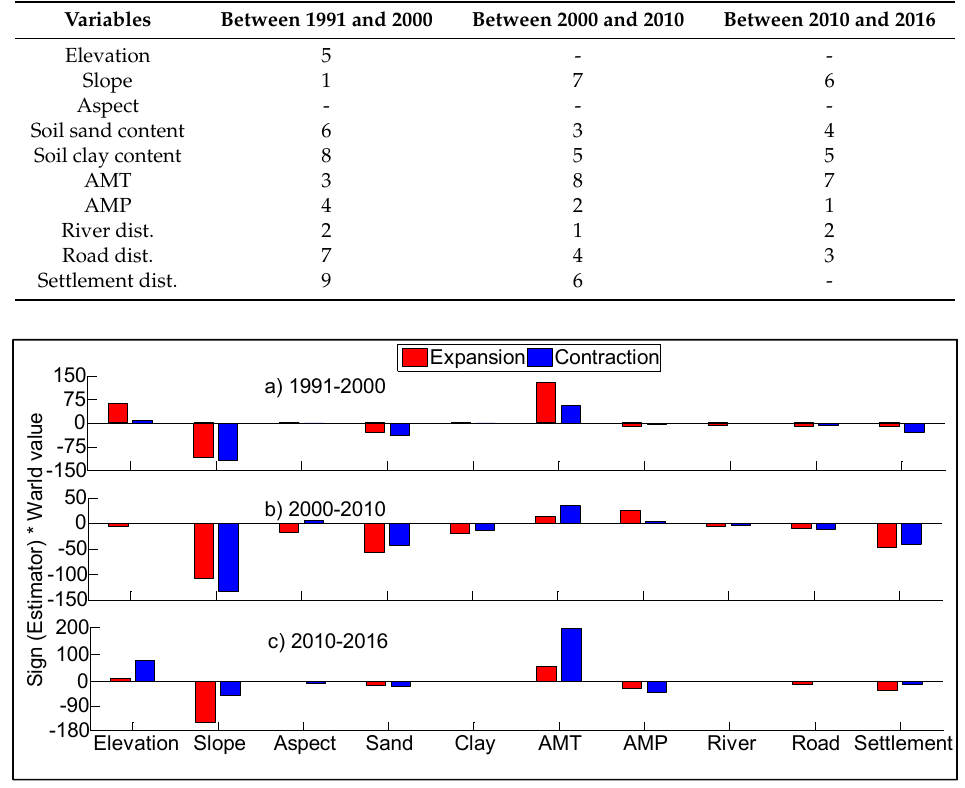
Table 11. Drivers of farmland contraction in our three LR models ranked in order of importance.